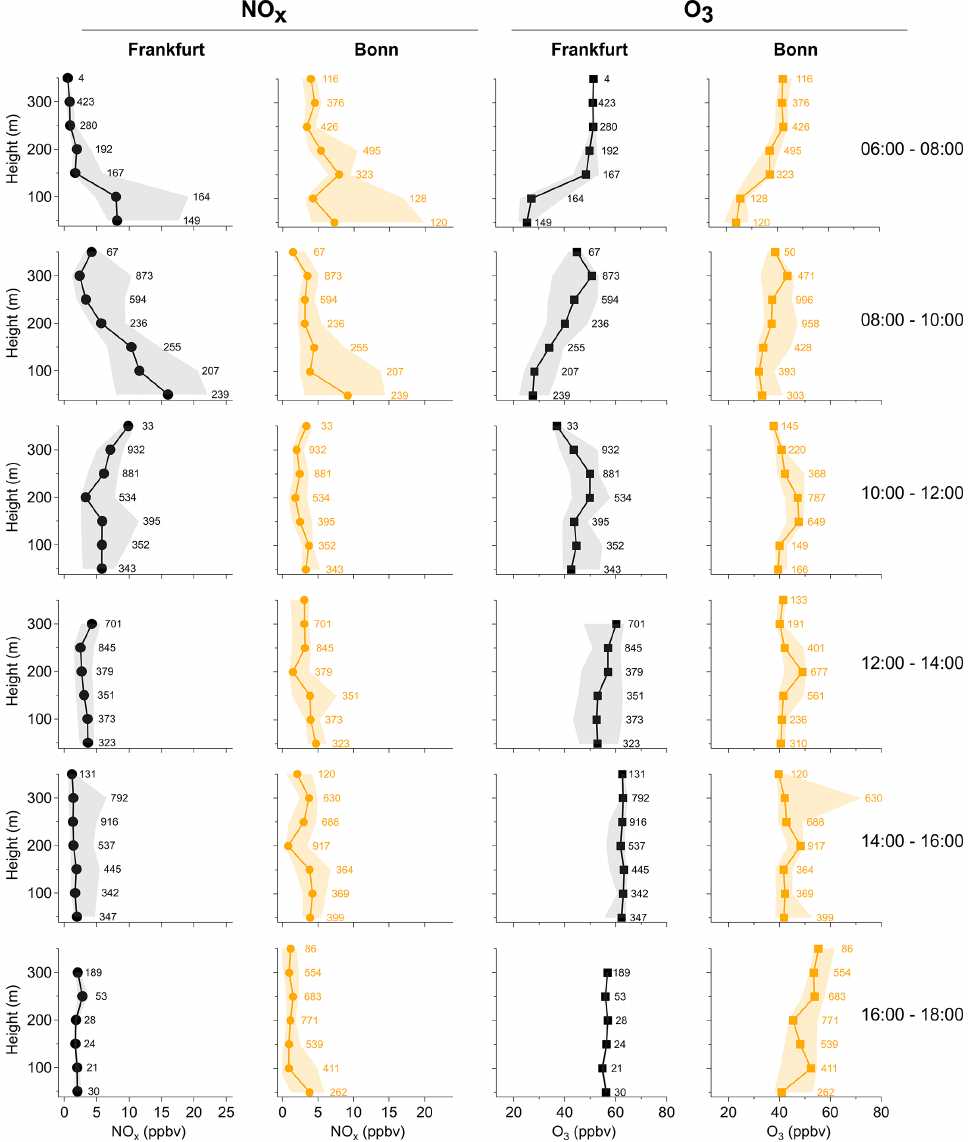
Figure 3. Vertical profiles for different time-periods (UTC) for NO x and O 3 in Bonn and Frankfurt. Circle and square markers correspond to the median NO x and O 3 mixing ratios, respectively. The shaded areas represent the 25th and 75th percentiles. Numbers correspond to the data points used to generate the NO x and O 3